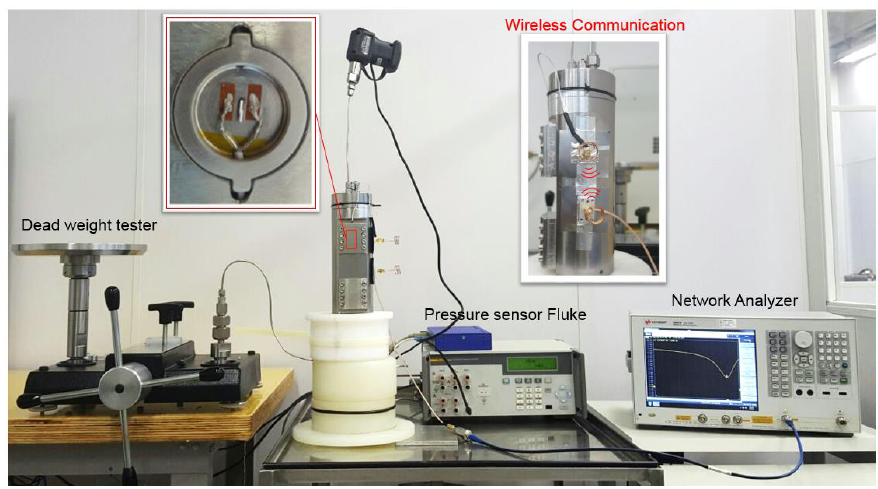
Figure 3. Setup for the pressure tests: in the left inset, the diaphragm instrumented with the SAW; at the center of the figure, the side view of the mandrel with antennas; and in the top-right inset, a plot of one of the load cycles.